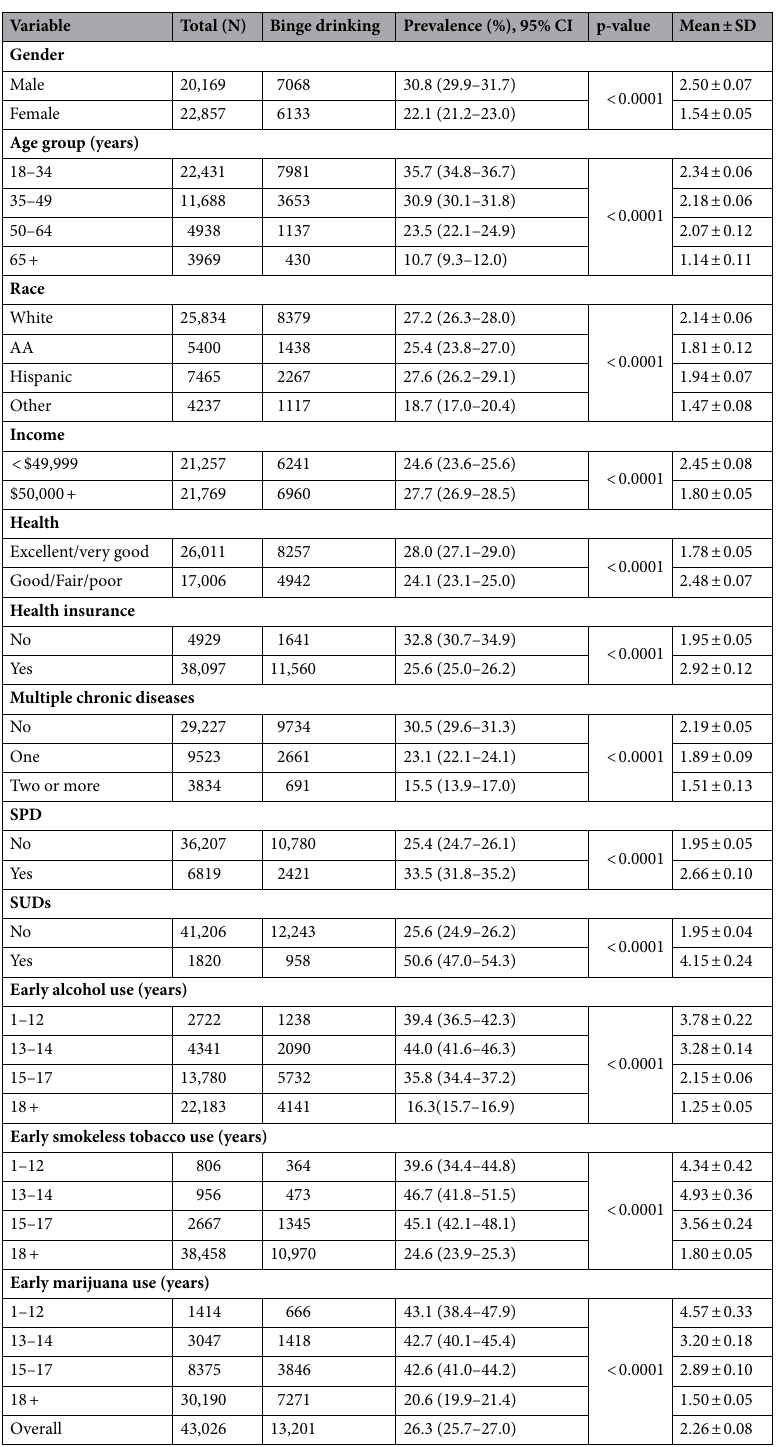
Table 1. Descriptive statistics of binge drinking across factors. AA African American, SPD serious psychological distress, SUDs substance use disorders, CI confidence interval, SD standard deviation. p-value is based on χ 2